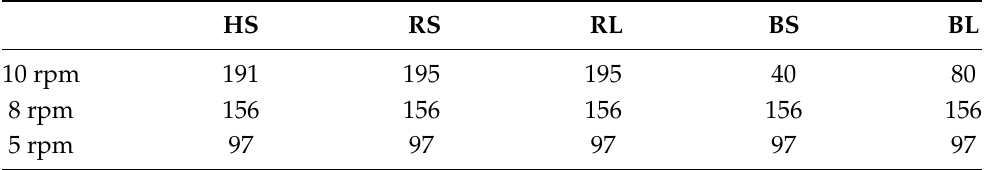
Table 1. Number of rotations for healthy scenario (HS), small raceway shaft washer damage scenario (RS), large raceway shaft washer damage scenario (RL), small ball bearing damage scenario (BS), and large ball bearing damage scenario (BL) at 5, 8, and 10 revolutions per minute (rpm).